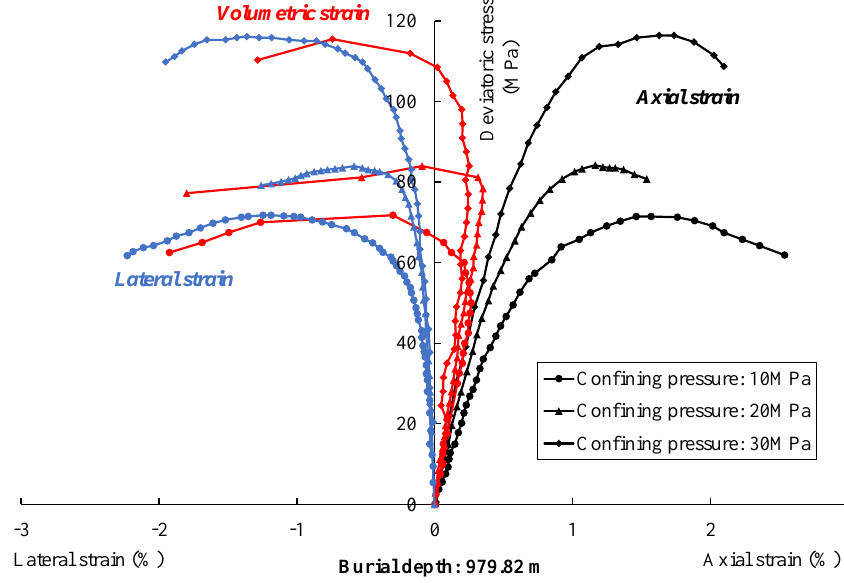
Figure 5. Typical stress-strain curves at different confining pressures in triaxial compression tests.